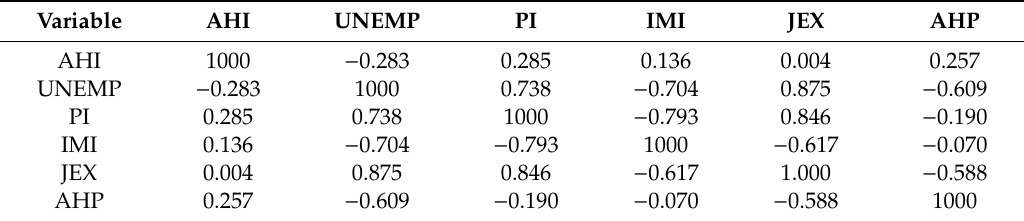
Table 6. Correlation indexes between economic and real estate variables.